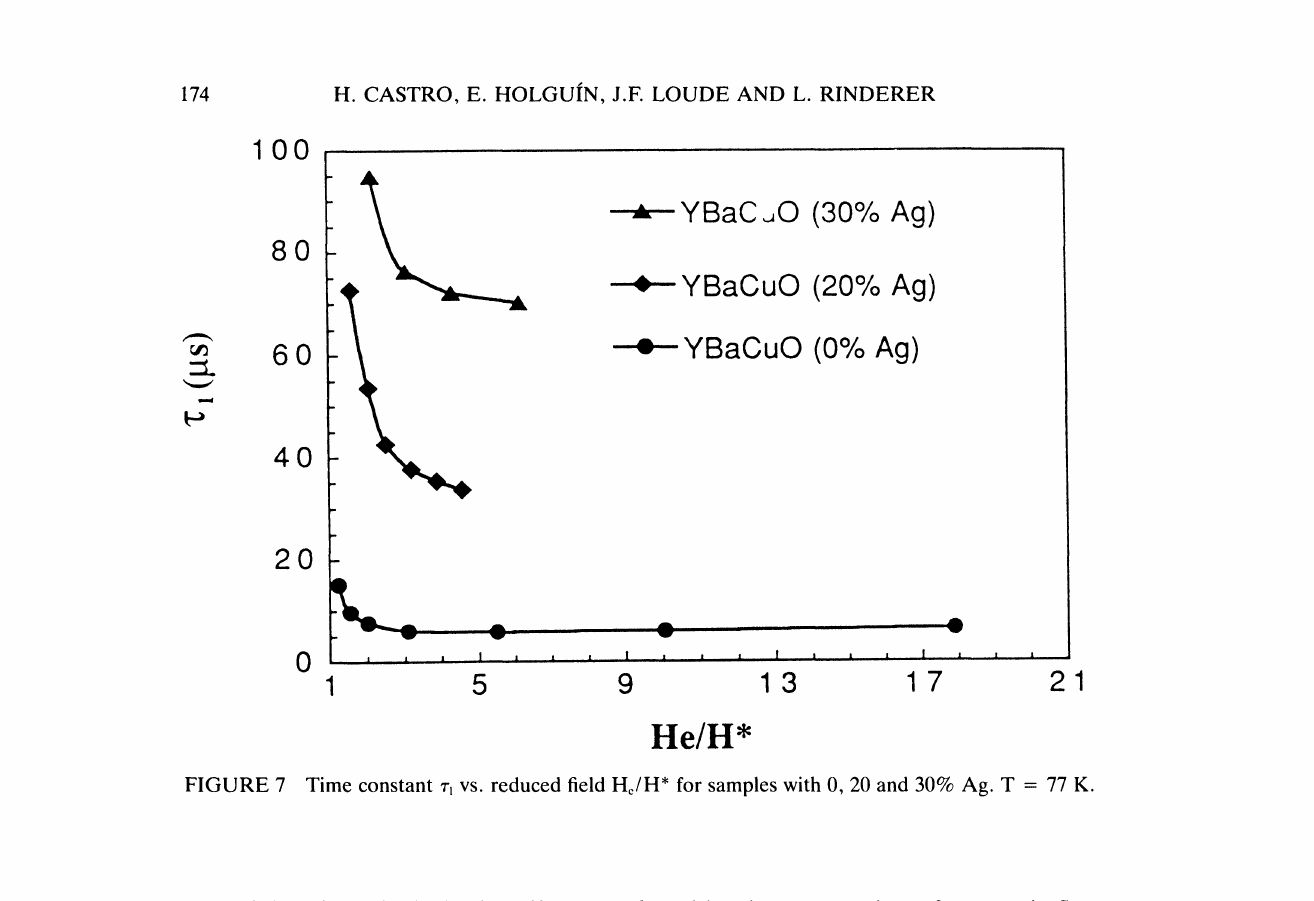
FIGURE 7 Time constant r vs. reduced field He/H* for samples with 0, 20 and 30% Ag. T 77